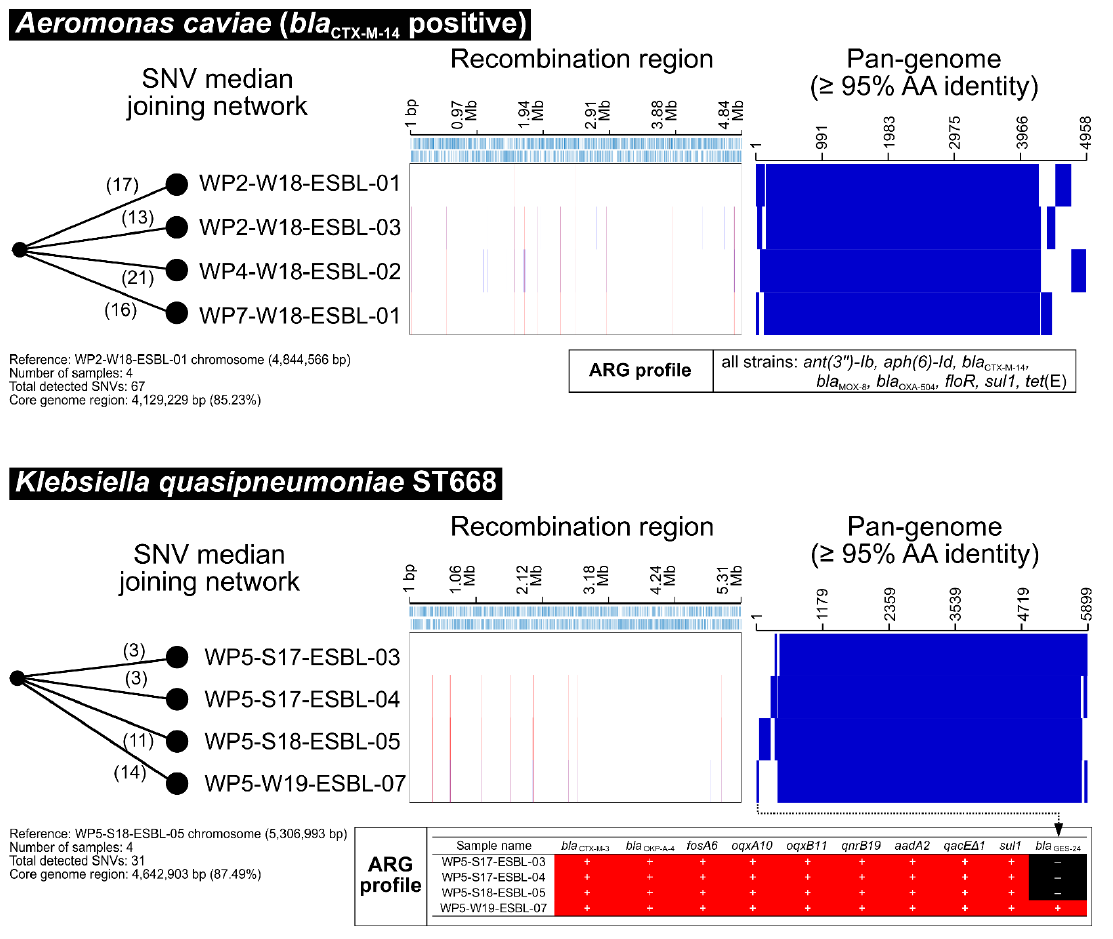
Figure 5. Characterization of other CTX-M-positive bacteria from WWTP effluents. Core genome SNV network, genome recombination, and pan-genome analysis of ( A ) A. caviae and ( B ) K. quasip- neumoniae isolates.